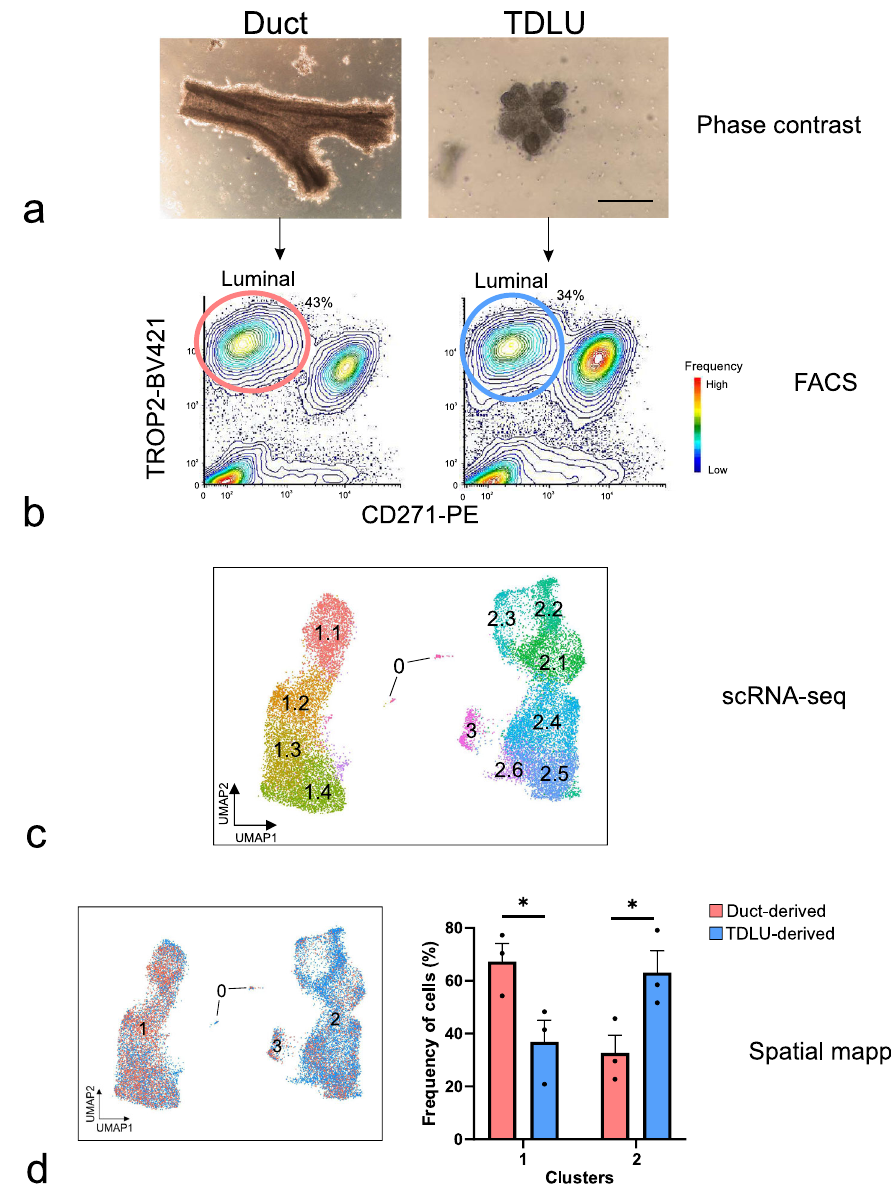
Fig. 1 Combined micro-collection, FACS, and scRNA-seq assign duct- and TDLU-derived cells to separate clusters. a Phase-contrast micrographs of micro-collected ducts (left) and TDLUs (right) from human breast organoids. Scale bar = 100 μ m. b FACS diagrams showing the gating of luminal cells (TROP2 + /CD271 − ) from ducts (red circle, left) and TDLUs (blue circle, right) for scRNA-seq. Colors in FACS diagrams indicate frequency (red = high, blue = low frequency). c Uniform Manifold Approximation and Projection (UMAP) plot showing the clustering of luminal cells of three age-matched biopsies (20,286 cells). Clusters are denoted by color and labeled in the plot. Clusters: 0 as immune cells, 1.1 – 1.4 as luminal progenitors, and 2.1 to 2.6 and 3 as mature luminal cells according to differentially expressed genes (DEGs), some of which are shown in Fig. 2a. d (left) Same UMAP plot as in c showing contribution of duct- (red) and TDLU-derived (blue) luminal cells. (right) Bar graph illustrating contribution (relative frequency of cells in percent) of duct- (red) and TDLU-derived (blue) luminal cells to groups 1 and 2 of clusters. Error bars represent mean + standard error of the mean (SEM), n = 3 biopsies. * p < 0.05 by two-tailed t -test. Source data are provided as a Source Data fi le.